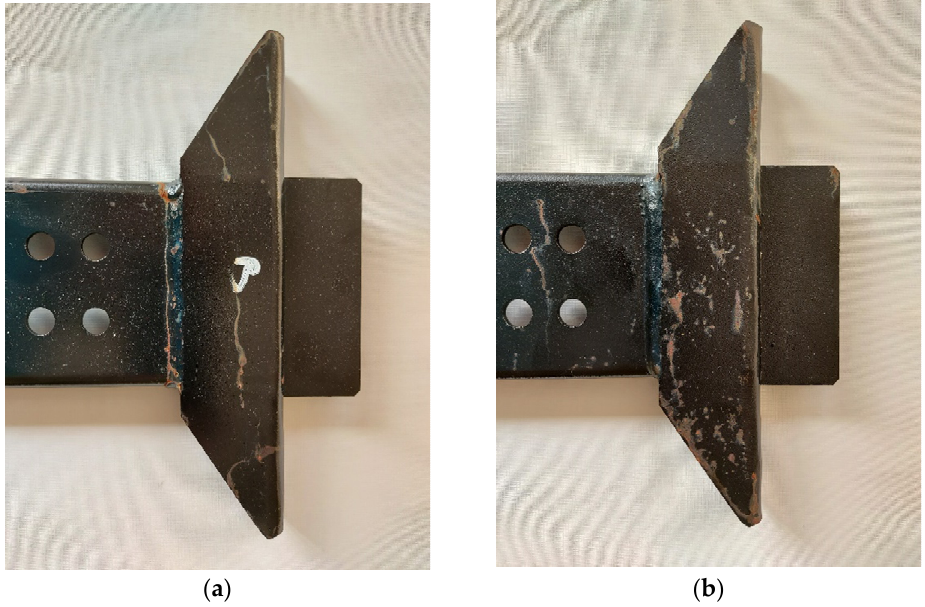
Figure 9. The view of the guide after corrosion resistance tests, ( a ) GROUP 1, ( b ) GROUP 2.